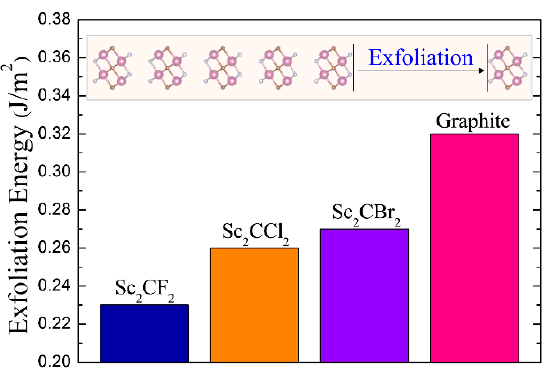
Figure 2. The calculated exfoliation energies of 2D Sc 2 CT 2 and graphite. The inset is the schematic of exfoliation process.